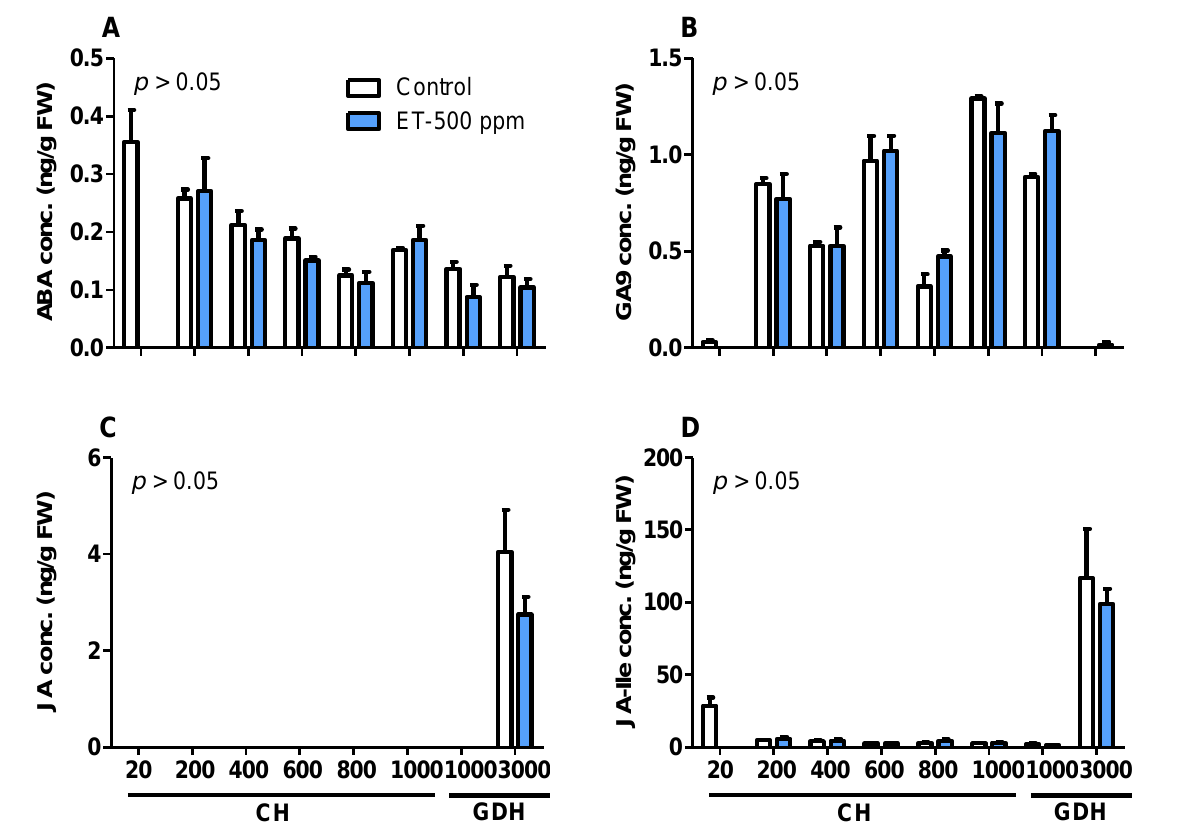
Figure 7. Hormone concentration of ABA ( A ), GA9 ( B ), JA ( C ), and JA-Ile ( D ) in floral buds of peach ‘Redhaven’ during endodormancy and ecodormancy. Each bar represents the mean ± SE of three biological replicates; p -values indicate comparisons between the control and ethephon treatment at 500 ppm. The CH (200, 600, 800, and 1000) and GDH (1000 and 3000) accumulation corresponds to the sampling dates of 11 November, 27 November, 9 December, and 27 December of 2019, and 15 January, 14 February, and 12 March of 2020, respectively. ABA, abscisic acid; GA, gibberellin; JA, jasmonic acid; and JA-Ile, Jasmonoyl isoleucine; CH, chilling hour; GDH, growing degree hour; conc., concentration; FW, fresh weight.